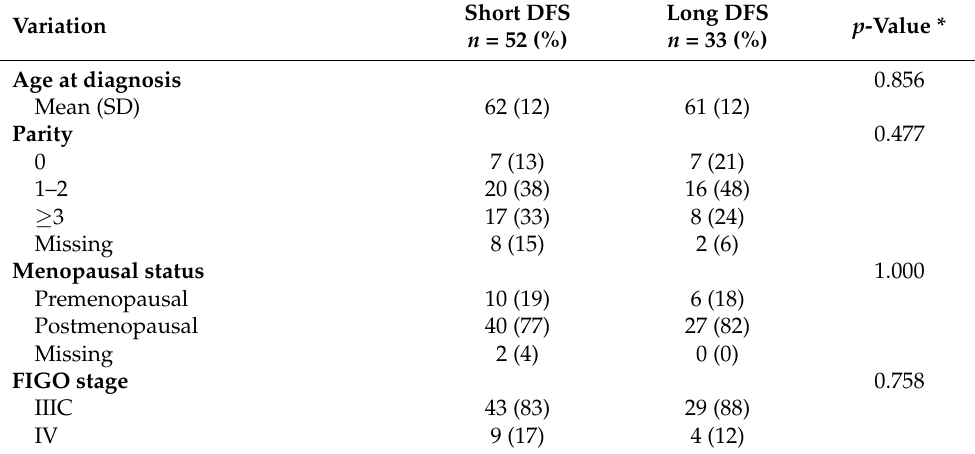
Table 1. Clinicopathological characteristics of the included women diagnosed with advanced stage high-grade serous ovarian carcinoma. Women were divided into two groups based on short (<12 months) and long (>24 months) disease-free survival